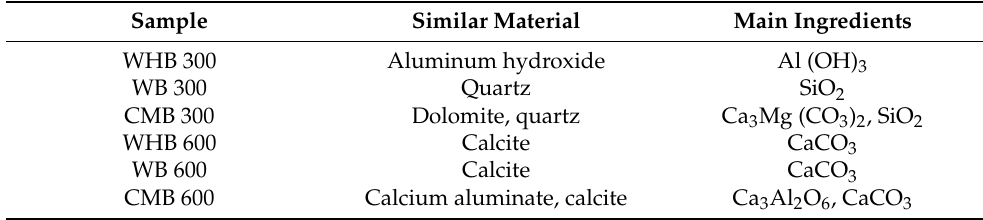
Table 5. Phase analysis results for all biochars.